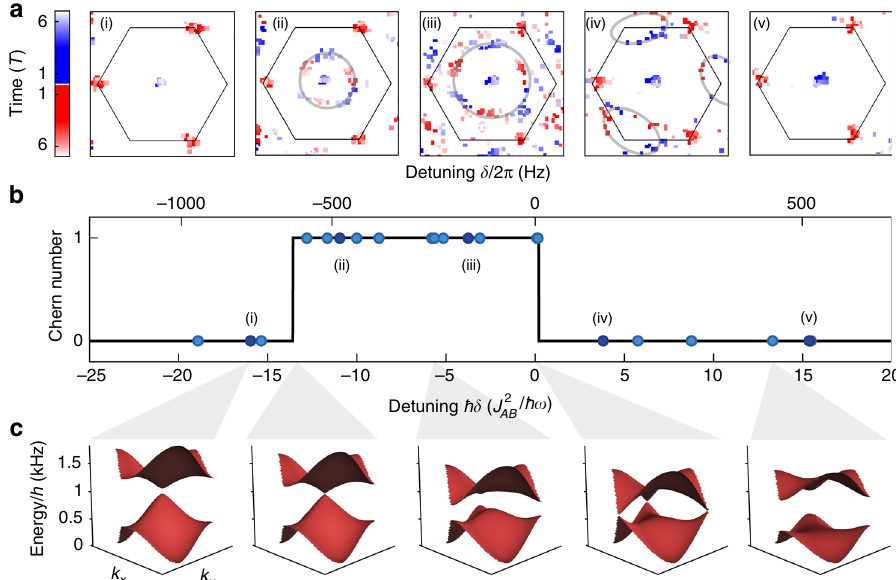
Fig. 8 Mapping out the topological phase diagram using the linking number. a Original data of the observed vortices summed over all time steps (red dot: positive chirality, blue dot: negative chirality; the hue indicates the time step where the vortex was present). The hexagon marks the fi rst Brillouin zone. The dynamical vortex contours are highlighted by a guide-to-the-eye (gray line). b The Chern number is obtained from the linking number of these dynamical vortex contours (or the absence of a contour) and plotted for various shaking detunings (cut through the phase diagram corresponding to the gray line in Fig. 3). The region with non-trivial Chern number agrees well with the prediction from a full numerical calculation (solid line). c Calculated Floquet bands for various detunings illustrating the closing of the Dirac points at the topological phase transitions